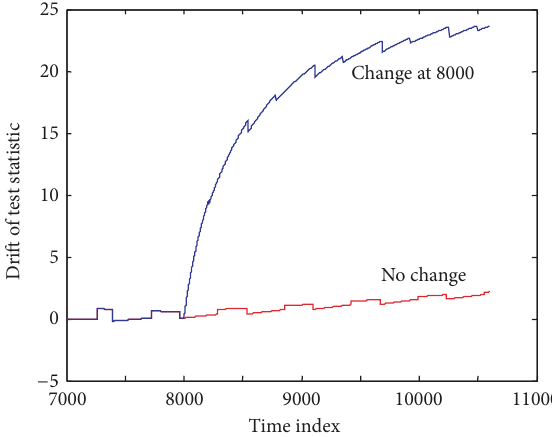
Figure 10: Drift of the test statistic for scenario I, under no change and a heat leakage starting at 𝑛 = 8000 .